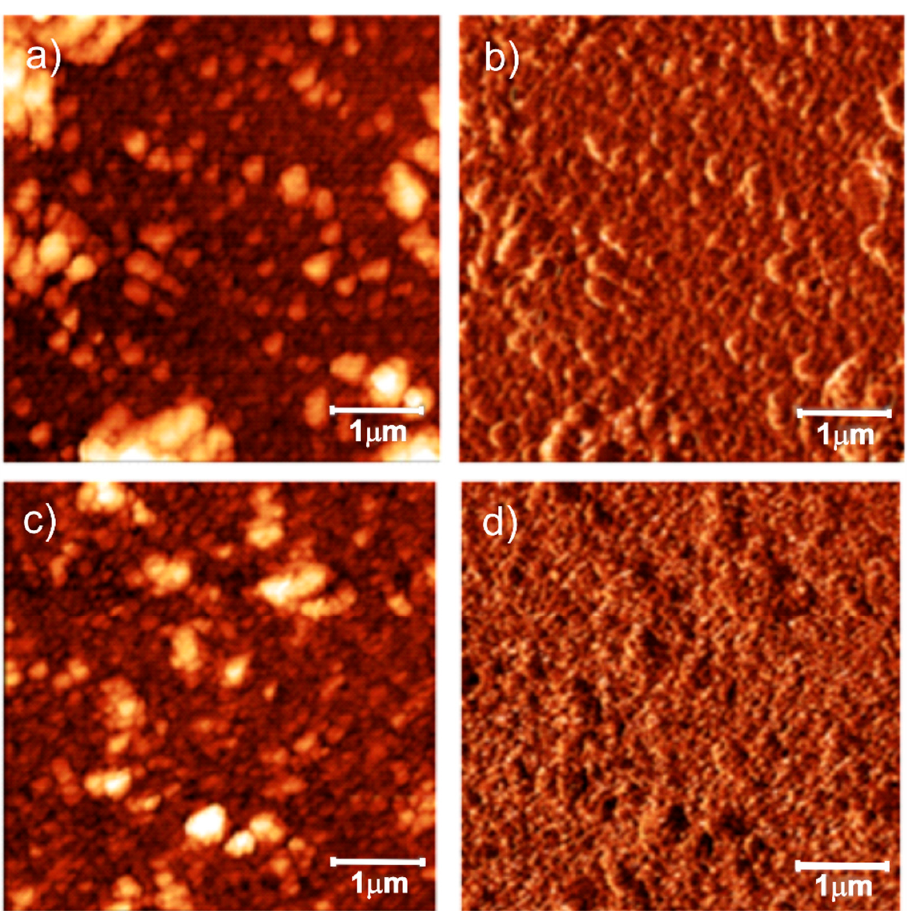
Figure 3. AFM topography (left) and force mode (right) images acquired from ( a , b ) PANI and ( c , d )